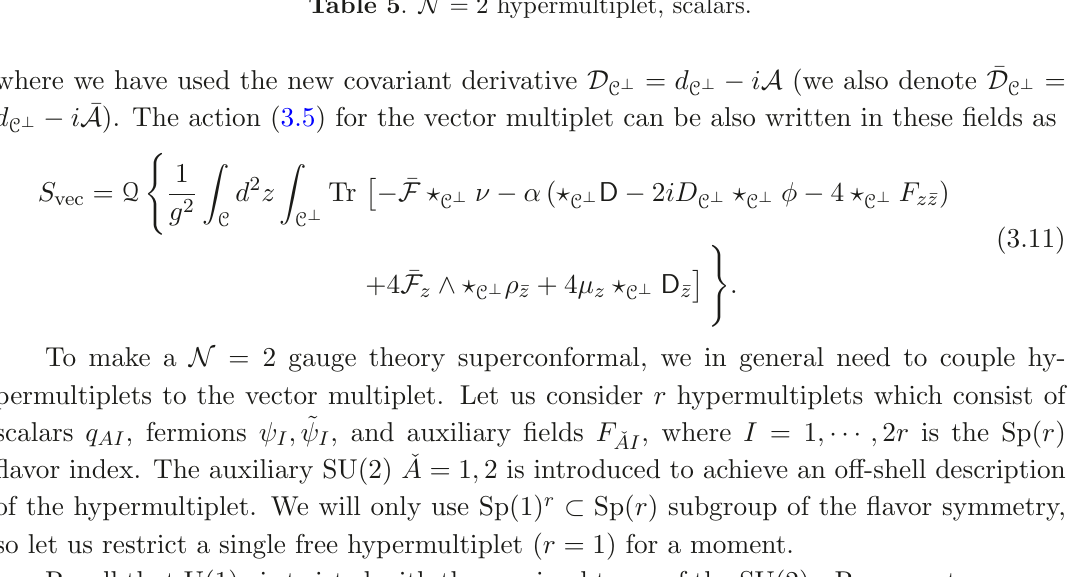
Table 5 . N = 2 hypermultiplet,